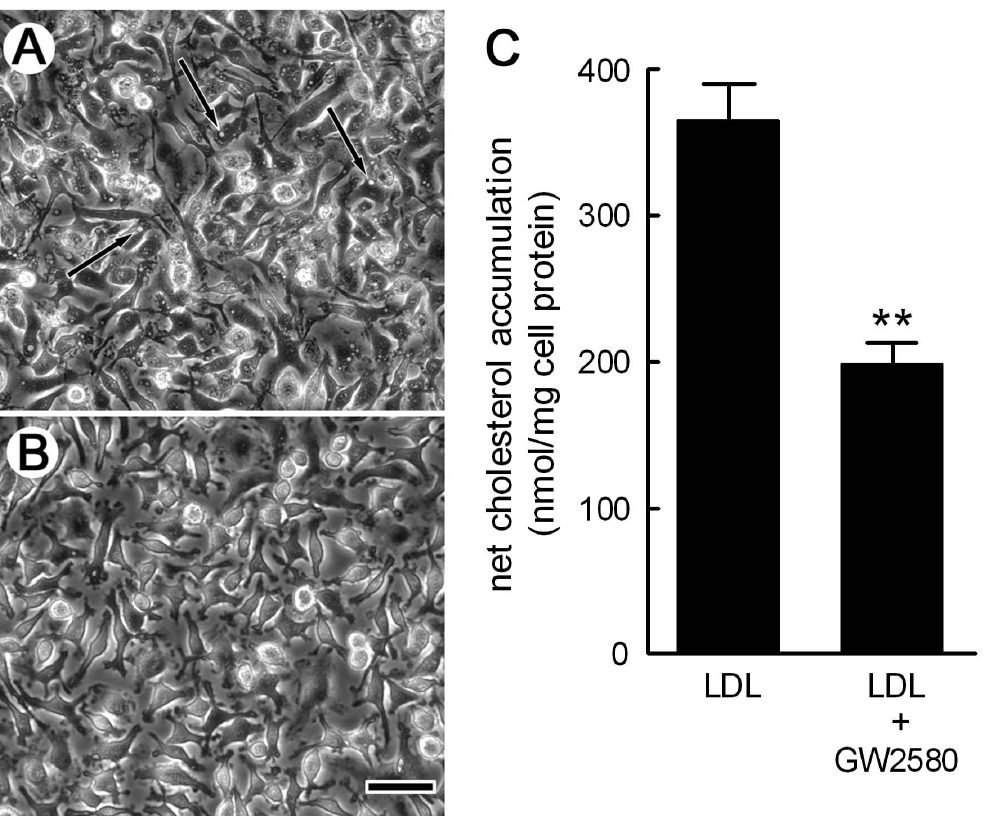
Figure 1. Macropinosome formation is M-CSF dependent. A and B. Wild-type macrophages were differentiated with M-CSF for 7 days and visualized by phase-contrast microscopy following the treatments described below. Macrophages differentiated with M-CSF were pretreated 30 min with DMSO drug vehicle (A), or 5 m M of cFMS (i.e., M-CSF receptor) tyrosine kinase inhibitor, GW2580 (B). Pretreatment was carried out without either serum or M-CSF. Withdrawal of M-CSF caused disappearance of the macrophage vacuoles. Subsequently, these macrophage cultures were treated 30 min with fresh serum-free medium containing M-CSF (50 ng/ml) without (A) or with GW2580 (B). Macrophages treated with M-CSF without GW2580 showed numerous vacuoles shown to be macropinosomes in Video S1. In contrast, there was complete inhibition of macropinosome formation when macrophage cultures were treated with GW2580 (also see Video S2). Scale bar in B=75 m m and also applies to A. (C) Wild-type macrophages were incubated 24 h with 1 mg/ml LDL without or with 5 m M GW2580, and then cholesterol accumulation was assessed. Macrophages incubated without LDL had 111 6 3 nmol cholesterol/mg protein. **= p , 0.01.